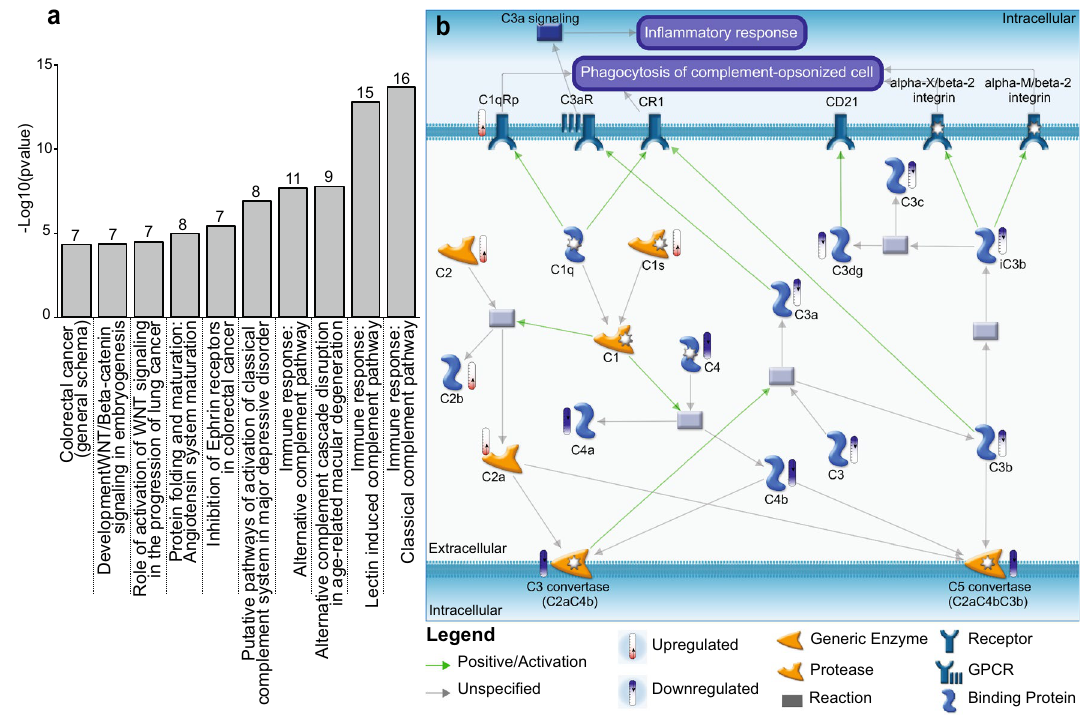
Figure 5. Canonical pathway enrichment analysis identifies immune response classical complement pathway as the ones most enriched in PVEC co-cultured with NPC. ( a ) Canonical pathway enrichment using the Metacore from Clarivate Analytics identified the top 10 most enriched pathways in PVEC vs. PVEC + NPC. ( b ) Depiction of the top most modified pathway, “Immune response: Classical complement pathway”. The legend included in the figure decodes the colored shapes and arrows used in the picture. Colored bars close to each protein name indicates whether the DEG was upregulated (red) or down-regulated (blue) upon co-culture of PVEC with